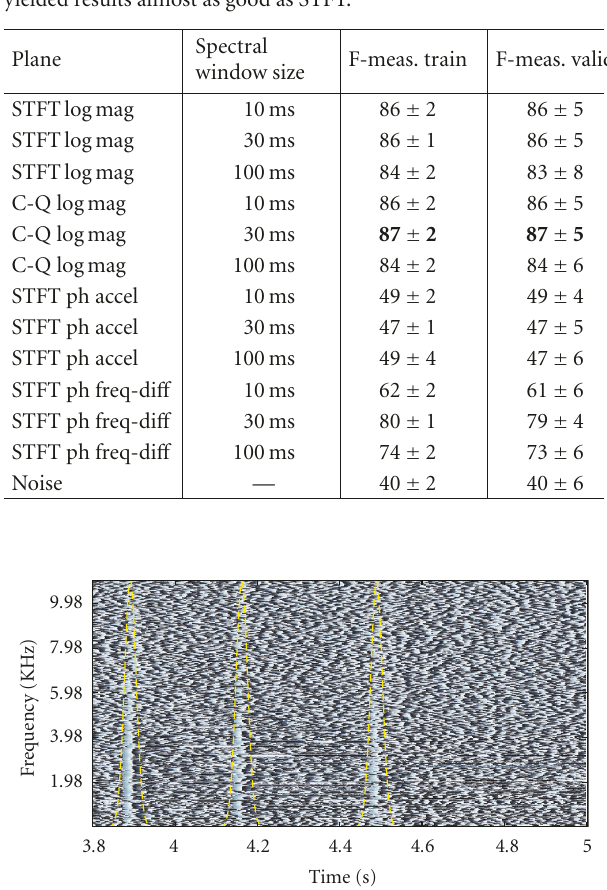
Table 1: Results for running the FNN on di ff erent kinds of repre- sentations. constant- Q performed the best, but the di ff erence be- tween Constant- Q and STFT is not significant. Phase acceleration did slightly better than noise, and phase di ff erence across frequency yielded results almost as good as STFT.